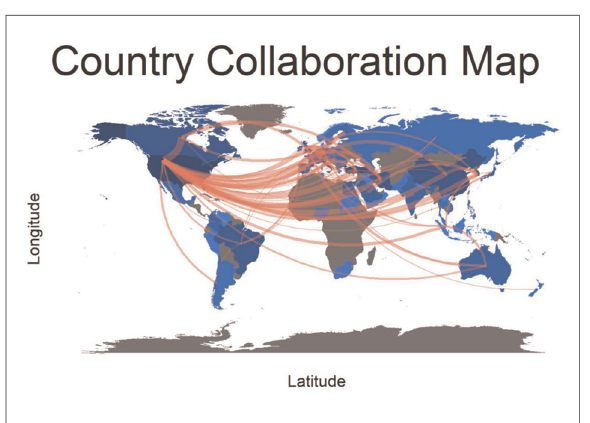
FIGURE 4 The worldwide country collaborative map in the fi eld of RP.